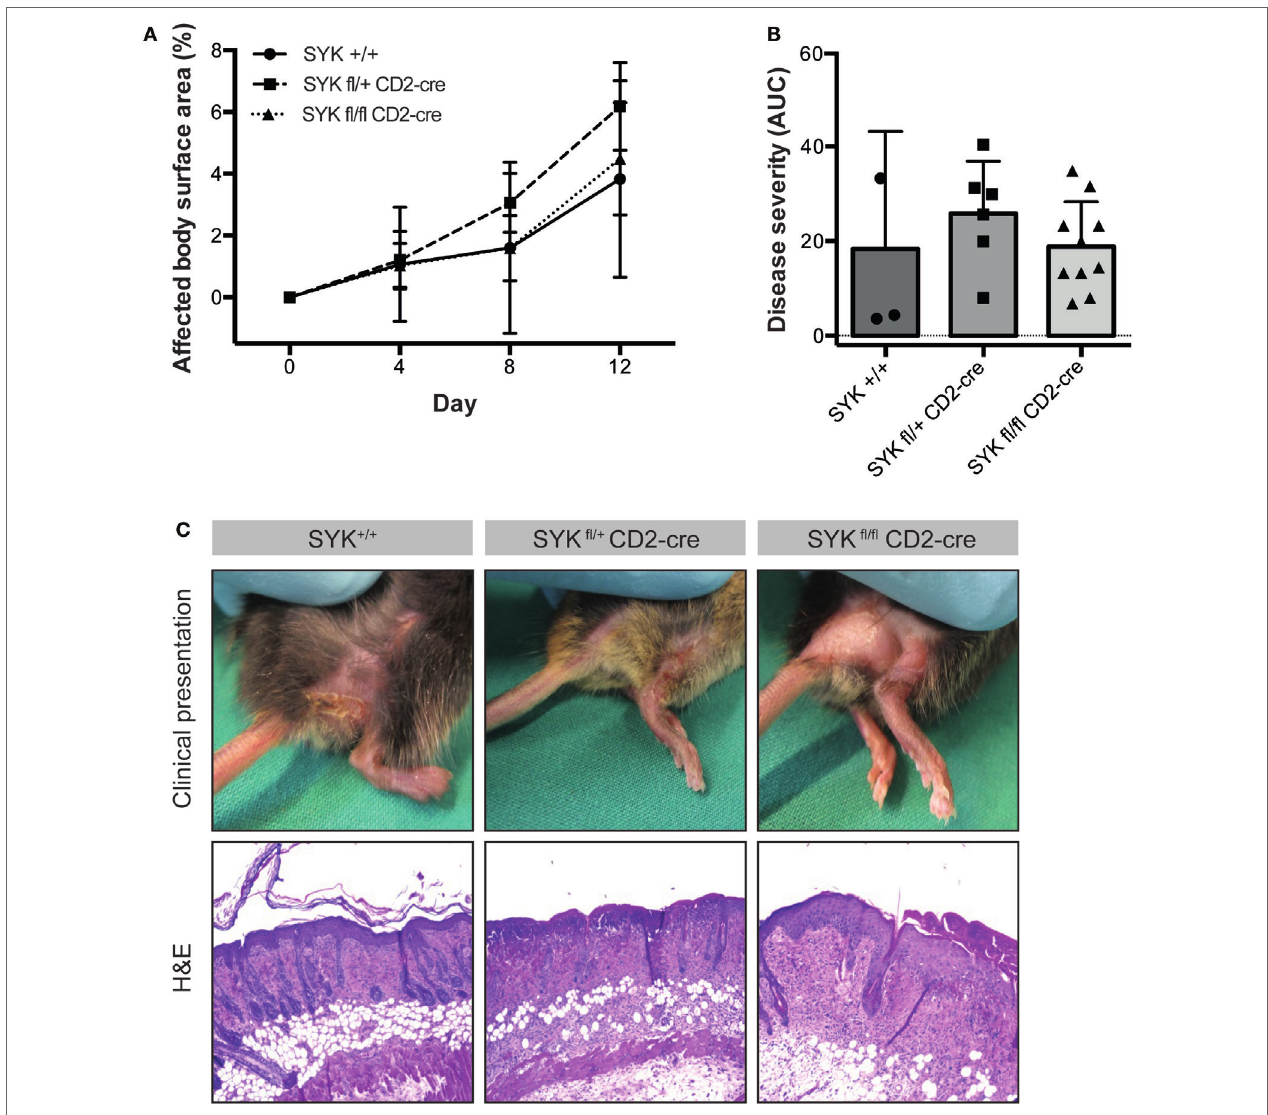
FigUre 5 | SYK fl/fl CD2-Cre mice develop blistering in antibody transfer-induced epidermolysis bullosa acquisita (EBA). (a) Mean (SD) of the affected body surface area after repetitive injections of anti-type VII collagen IgG into the indicated mouse strains over the 12-day observation period ( n = 3–9/strain). In contrast to the SYK fl/fl LysM-cre mice, mice with the specific deletion of SYK in lymphoid cells were completely susceptible to EBA induction. (B) The cumulative disease severity [expressed as the area under the curve (AUC)] calculated from the graphs in panel (a) is shown. The individual dots correspond to the AUCs of individual mice. (c) Representative clinical images and H&E-stained sections from the back skin of the indicated mouse strains (100 × original magnification). All images shown are from day 12 of the